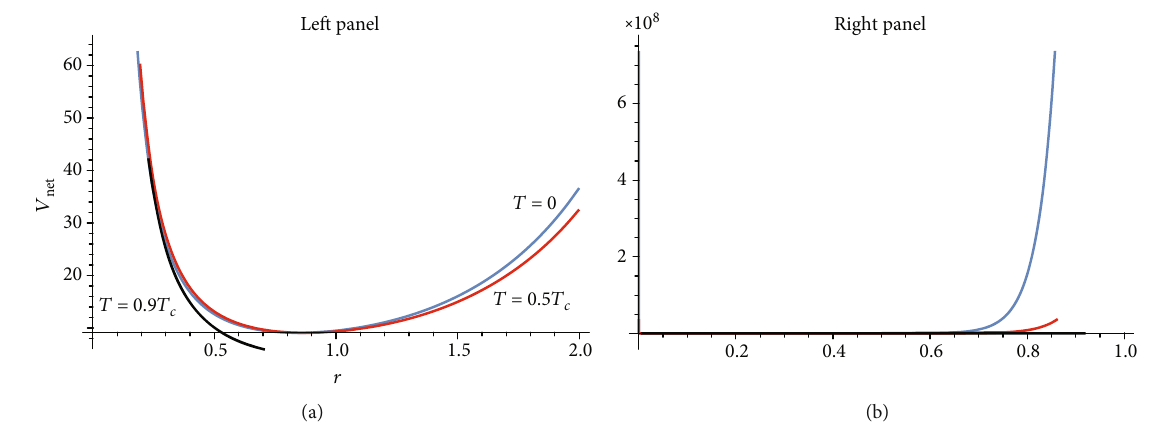
, T Þ , against r , T for m net ð r